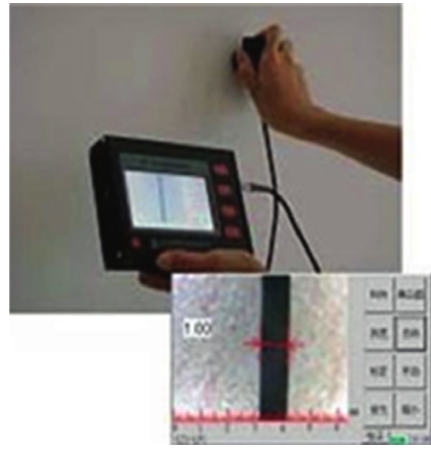
Figure 1: Manual detection